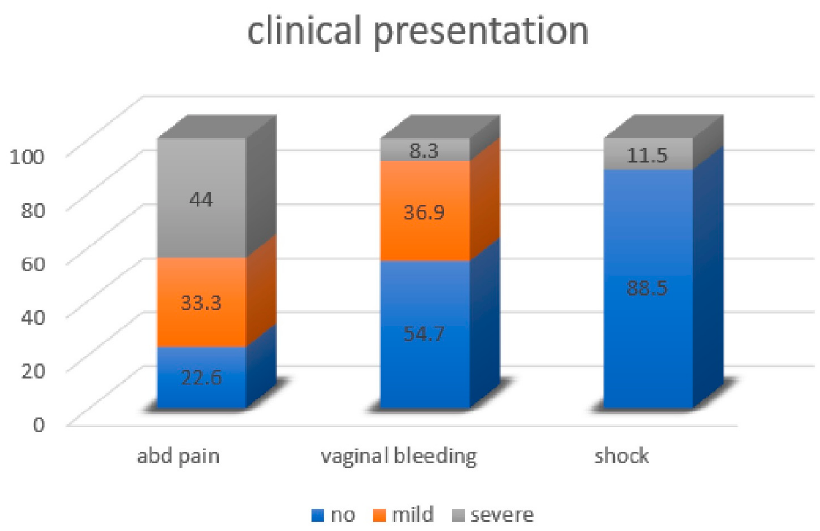
Figure 5. Presenting symptoms of ovarian pregnancies.